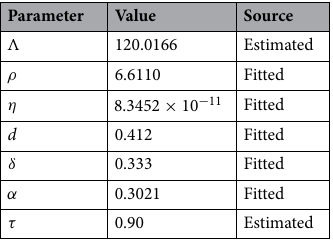
Table 1. Biological parameters used in the proposed NoV